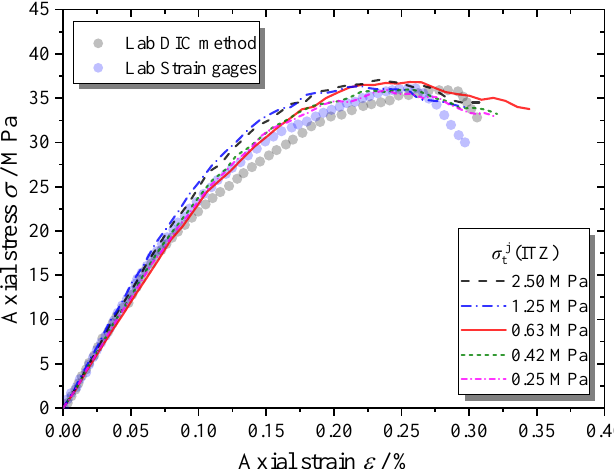
Figure 23. Complete compressive stress–strain curves of MRAC specimen with various ITZ tensile strength values.